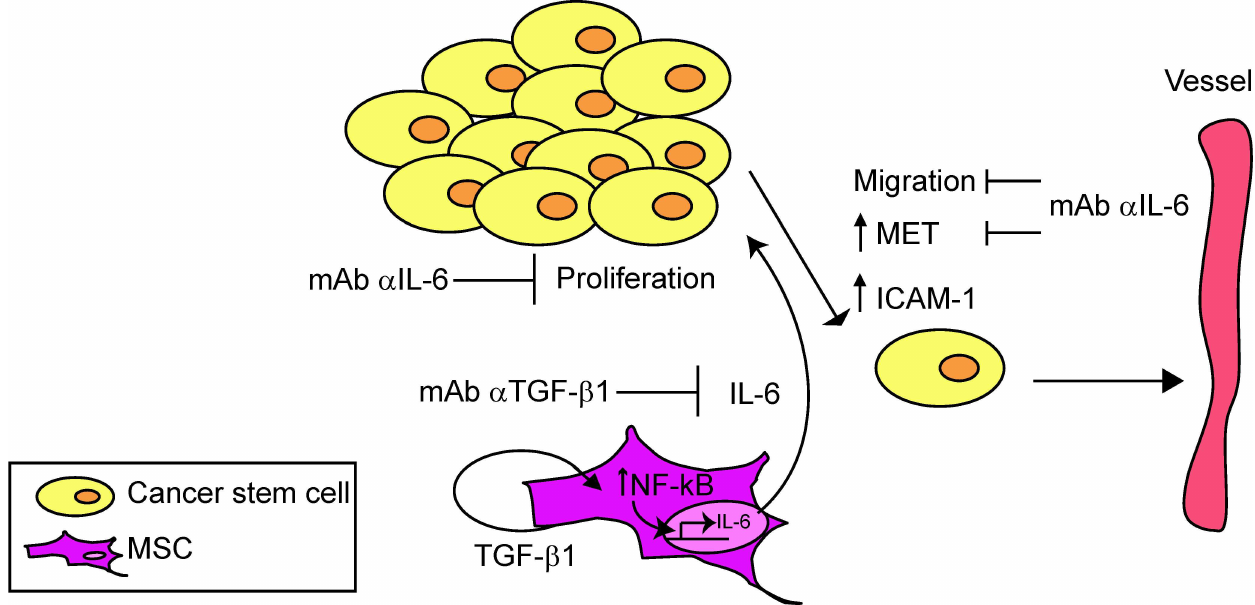
Fig 10. Model for the circuit between MSC and HOS-CSC. Recruitment of MSC to the tumor environment leads to enhanced proliferationof OS stem cells. The presenceof CSC, in turn, leads to a consistent secretionof TGF β 1 that activates a stromal autocrineloop that might be responsible for the activationof NF-kB genes and IL-6 secretion by MSC. Indeed, neutralization of TGF β 1 reducesthe amount of secreted IL-6. Pro-tumorigenic effects of MSC, via IL-6, including inductionof HOS-CSC migrationand spheregrowth, can be counteracted also by IL-6 neutralizingantibody. The presenceof MSC is also responsible for increasedexpressionof adhesion moleculesinvolvedin intra- or extra- vasationand the expressionof MET can be counteracted by IL-6 neutralization.